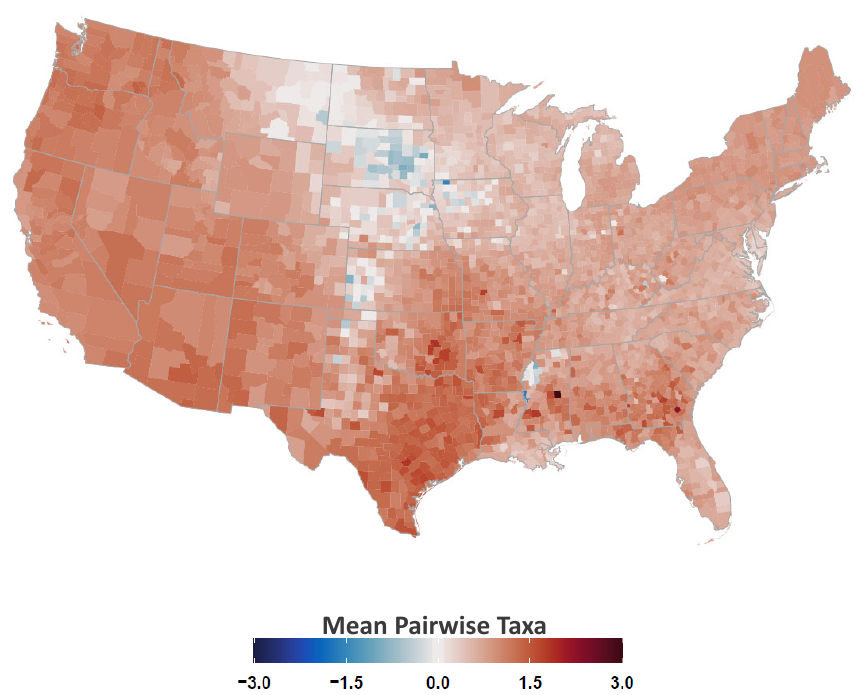
Figure A13. Static avian mean pairwise taxa distance. Mean pairwise taxa covariate under as- sumption of a static species pool (May–August). Covariate reflects average phylogenetic distance among co-occurring species pairs in a community. Mapped values have been centered to highlight locations subject to relative phylogenetic clustering (higher than expected relatedness, blue colors) and dispersion (lower than expected relatedness, red